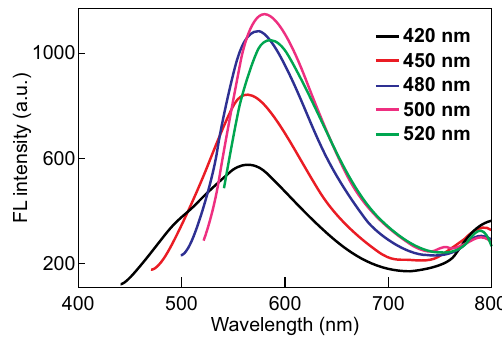
Fig. 2 Fluorescence emission spectra of MSNs–CDs under diverse excitation